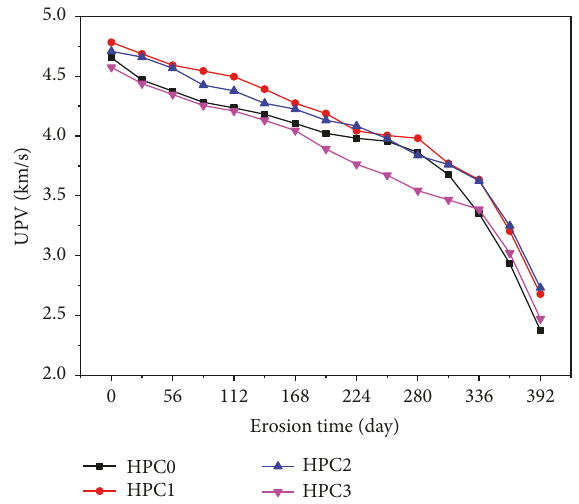
Figure 7: UPV of HPCs before and after exposure to sulfate